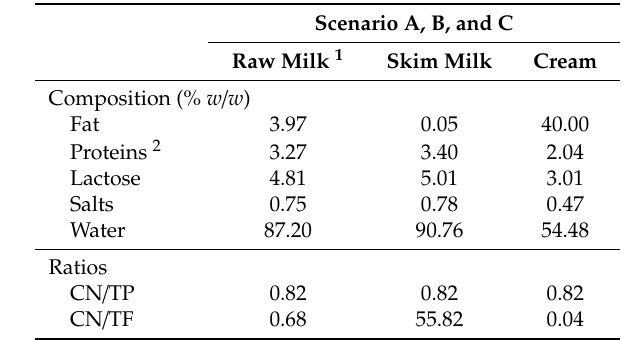
Table 3. Composition of the raw milk, skim milk, and cream at the standardization step for scenarios A, B, and C.